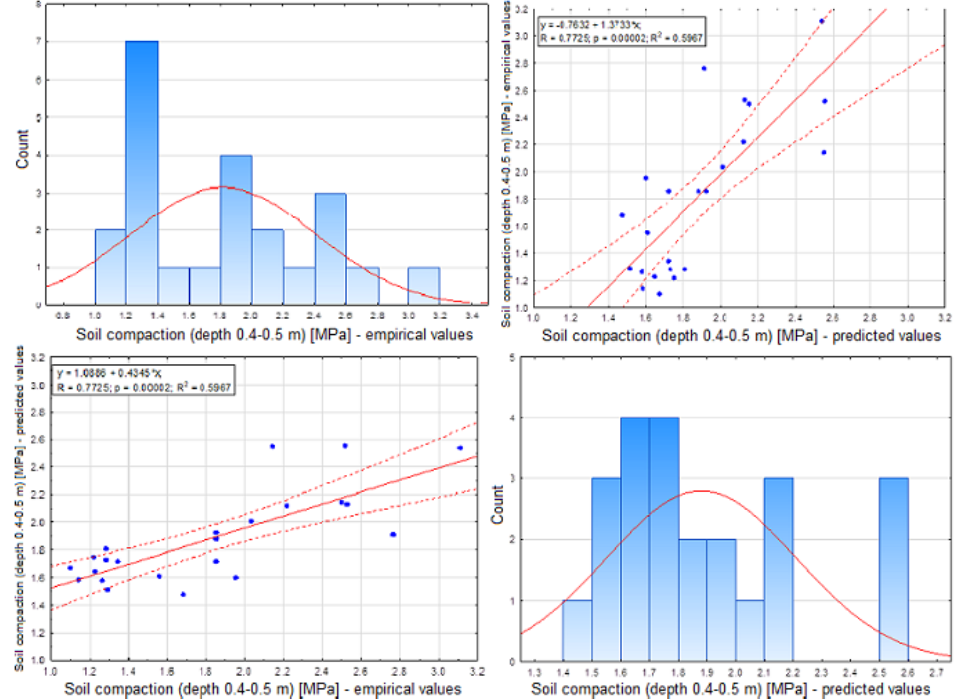
Figure 4. The scatter matrix graph for the validation dataset (MLPSC_0.4_0.5 model).